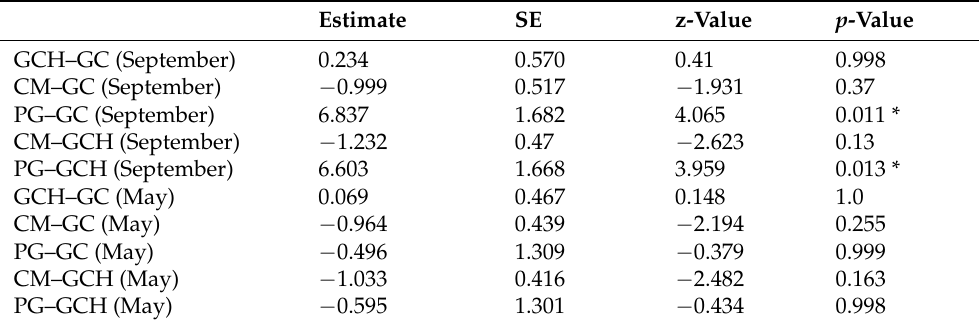
Table A12. Differences in activity densities of flightless/immobile carabid beetles, comparing grass– clover (GC) and grass–clover herbs (GCH) with each other, and in comparison to conventional maize (CM) and permanent grasslands (PG) in May/June and September. p -values are indicated as * p < 0.05.